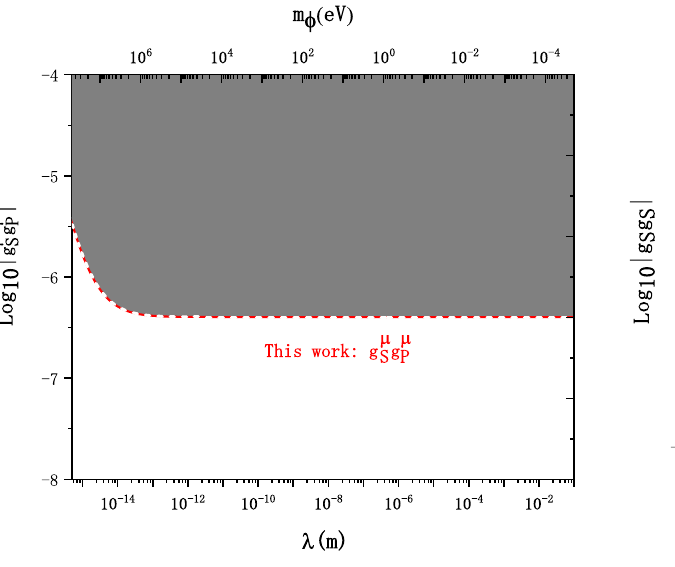
μ μ Fig. 3 Constraints to the coupling constant product | g e | as a func- g S P of the interaction range λ (ALP mass). The (red) dashed line is the result of this work